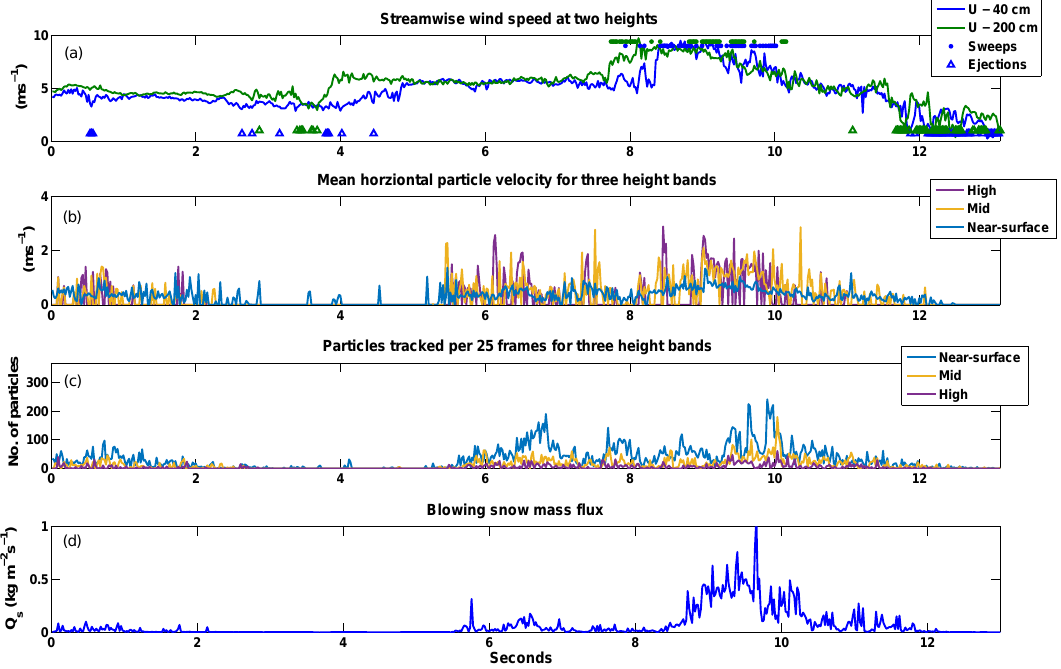
Figure 9. Recording no. 3 time series for 23 March: (a) 50Hz streamwise wind speed at 40 and 200cm above snow surface; (b) 50Hz snow particle velocities obtained by binning particle vectors in three height bands (1 < z < 4mm, near-surface; 4 < z < 8mm, middle; 8 < z < 30mm, high), then temporally averaged over 25 frames; (c) number of tracked particles in same height bands per 25 frames; (d) instantaneous blowing snow flux rates Q s (kgm 2 s − 1 )